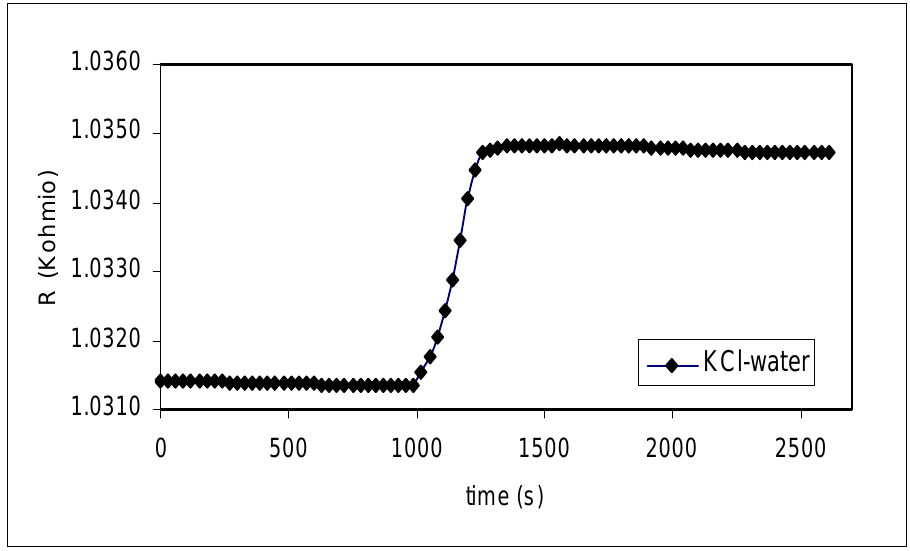
Figure 7. Thermogram for the Determination of the Enthalpy of Solution for KCl-Water